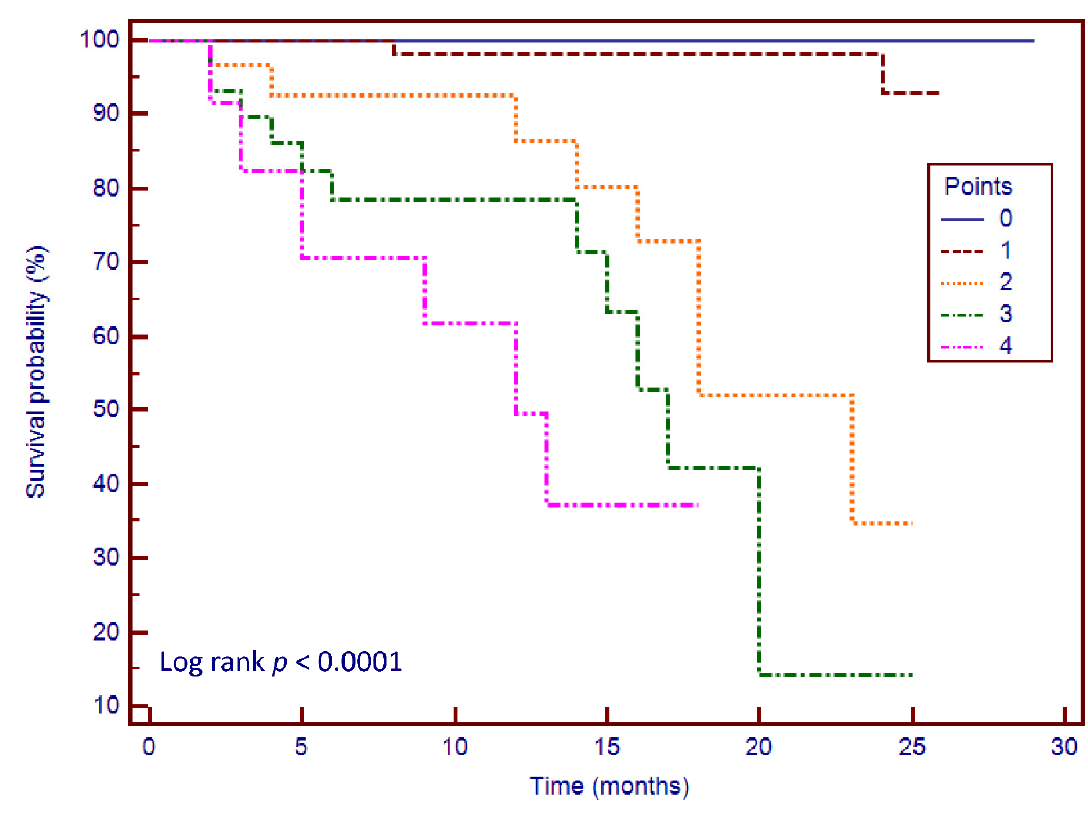
Figure 5. Kaplan-Meier curves for the risk stratification score. The scoring system ranges from 0 to 4 points: 1 point for each of the following LVEF < 30%, LGE + , LAS > − 7.8% and LVSI > 0.48. Abbreviations: LAS, left ventricular long axis strain; LGE, left ventricular late gadolinium enhancement; LVSI, left ventricular sphericity index.